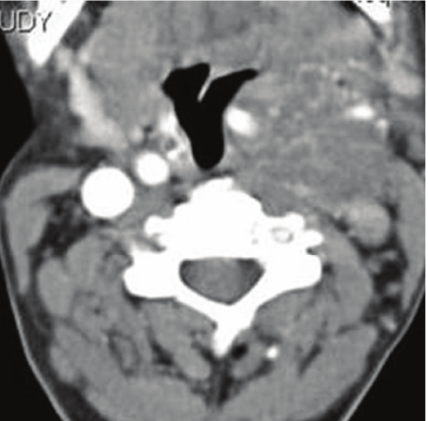
Figure 9: On CT scan, neck with contrast reveals a predominantly isodense mass on the left parapharyngeal space showing mild heterogeneous contrast enhancement. Note the insinuation of the mass between internal and external carotid arteries with resultant splaying of internal and external carotid arteries.